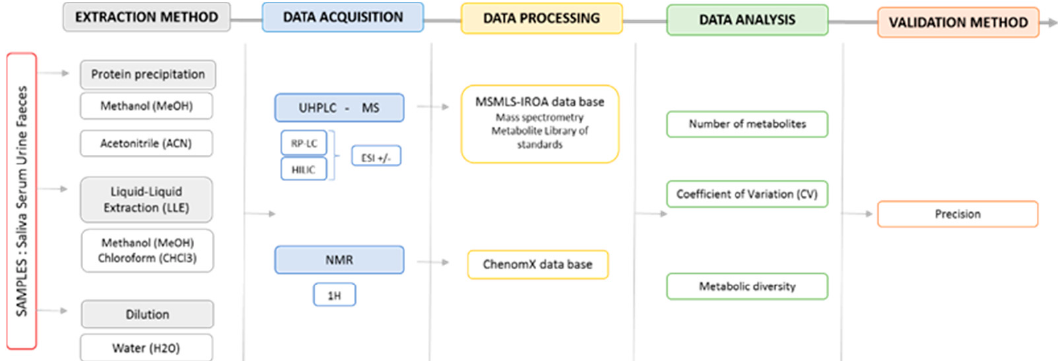
Figure 1. Schematic presentation of the global workflow of preparation procedures applied to urine, saliva, blood and feces pools for the selection of the optimum protocol for the maximum metabolome coverage by LC-MS and 1 H-NMR.